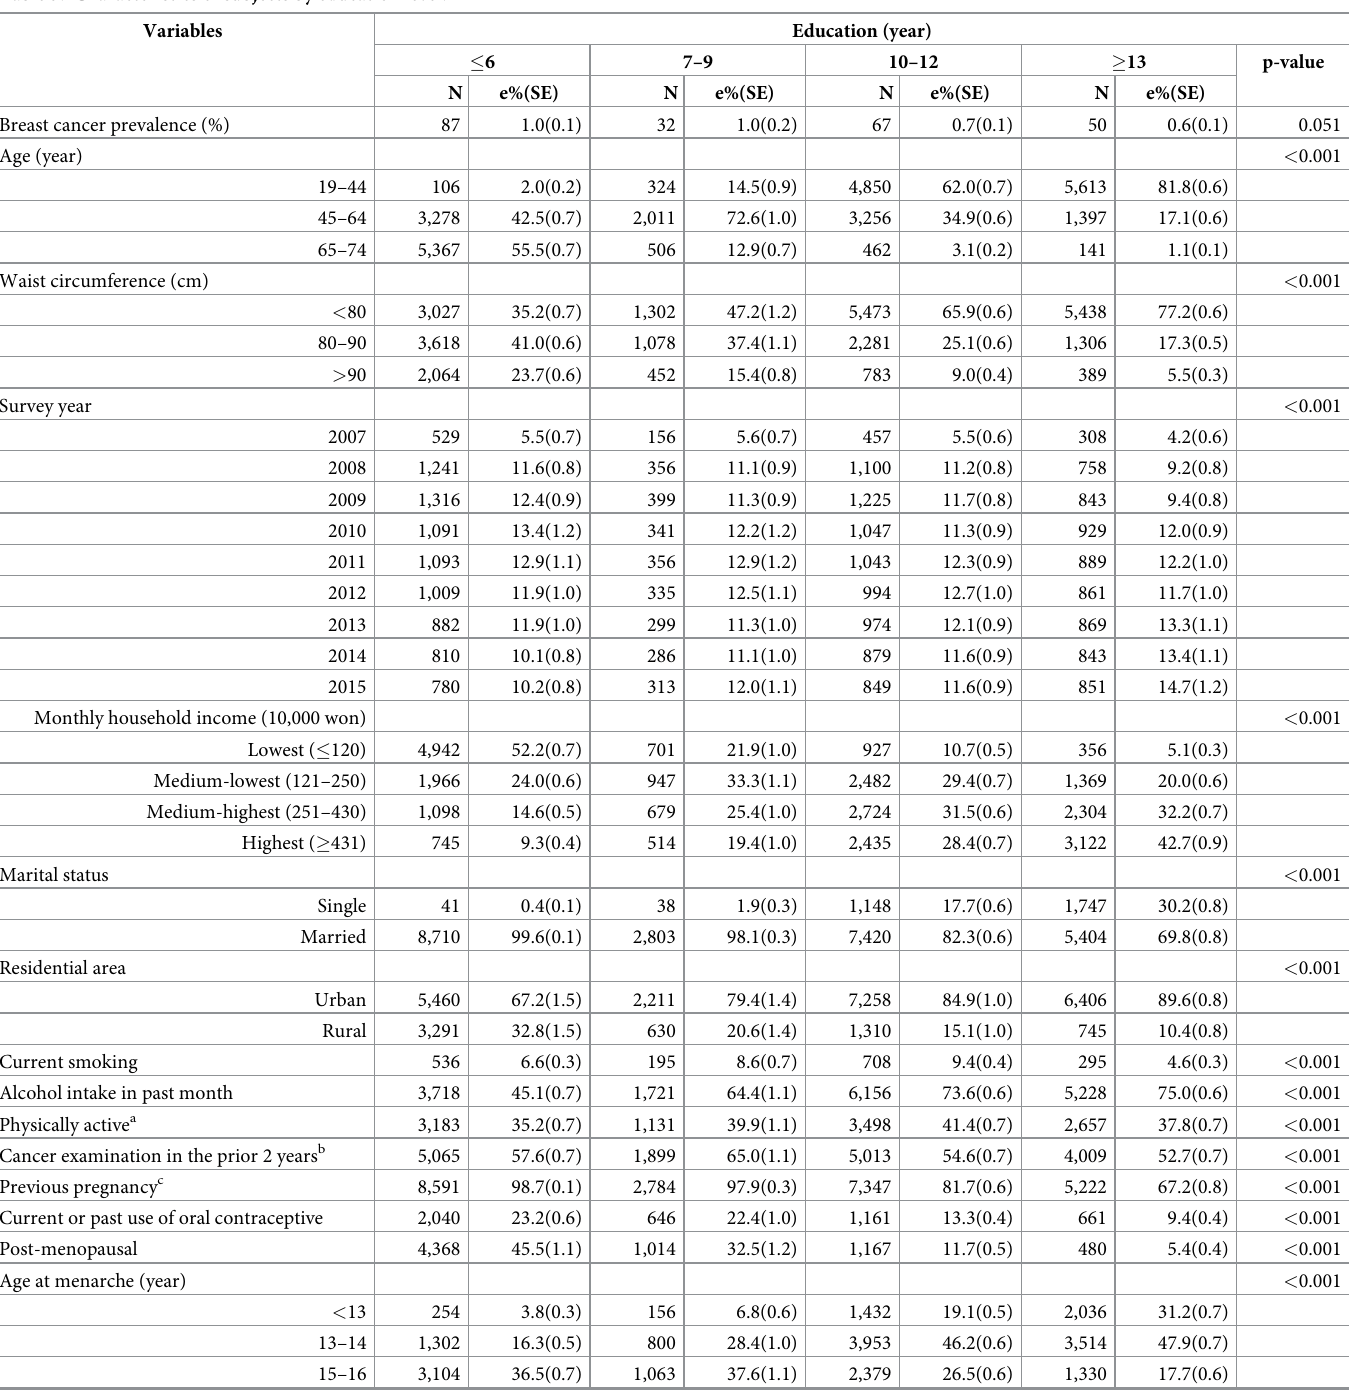
Table 3. Characteristics of subjects by education